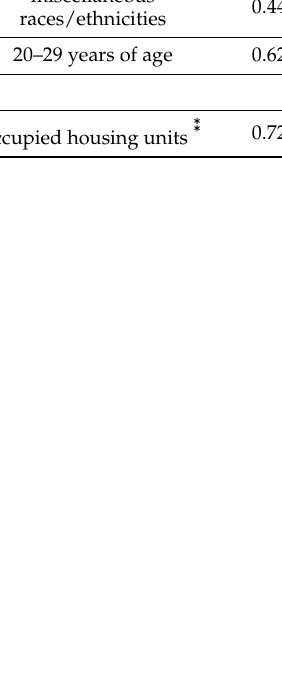
Table 4. Selected Manly transformed 2010% and density attribute variables experiencing improve- ment in their individual correspondences with a Gaussian probability density function.